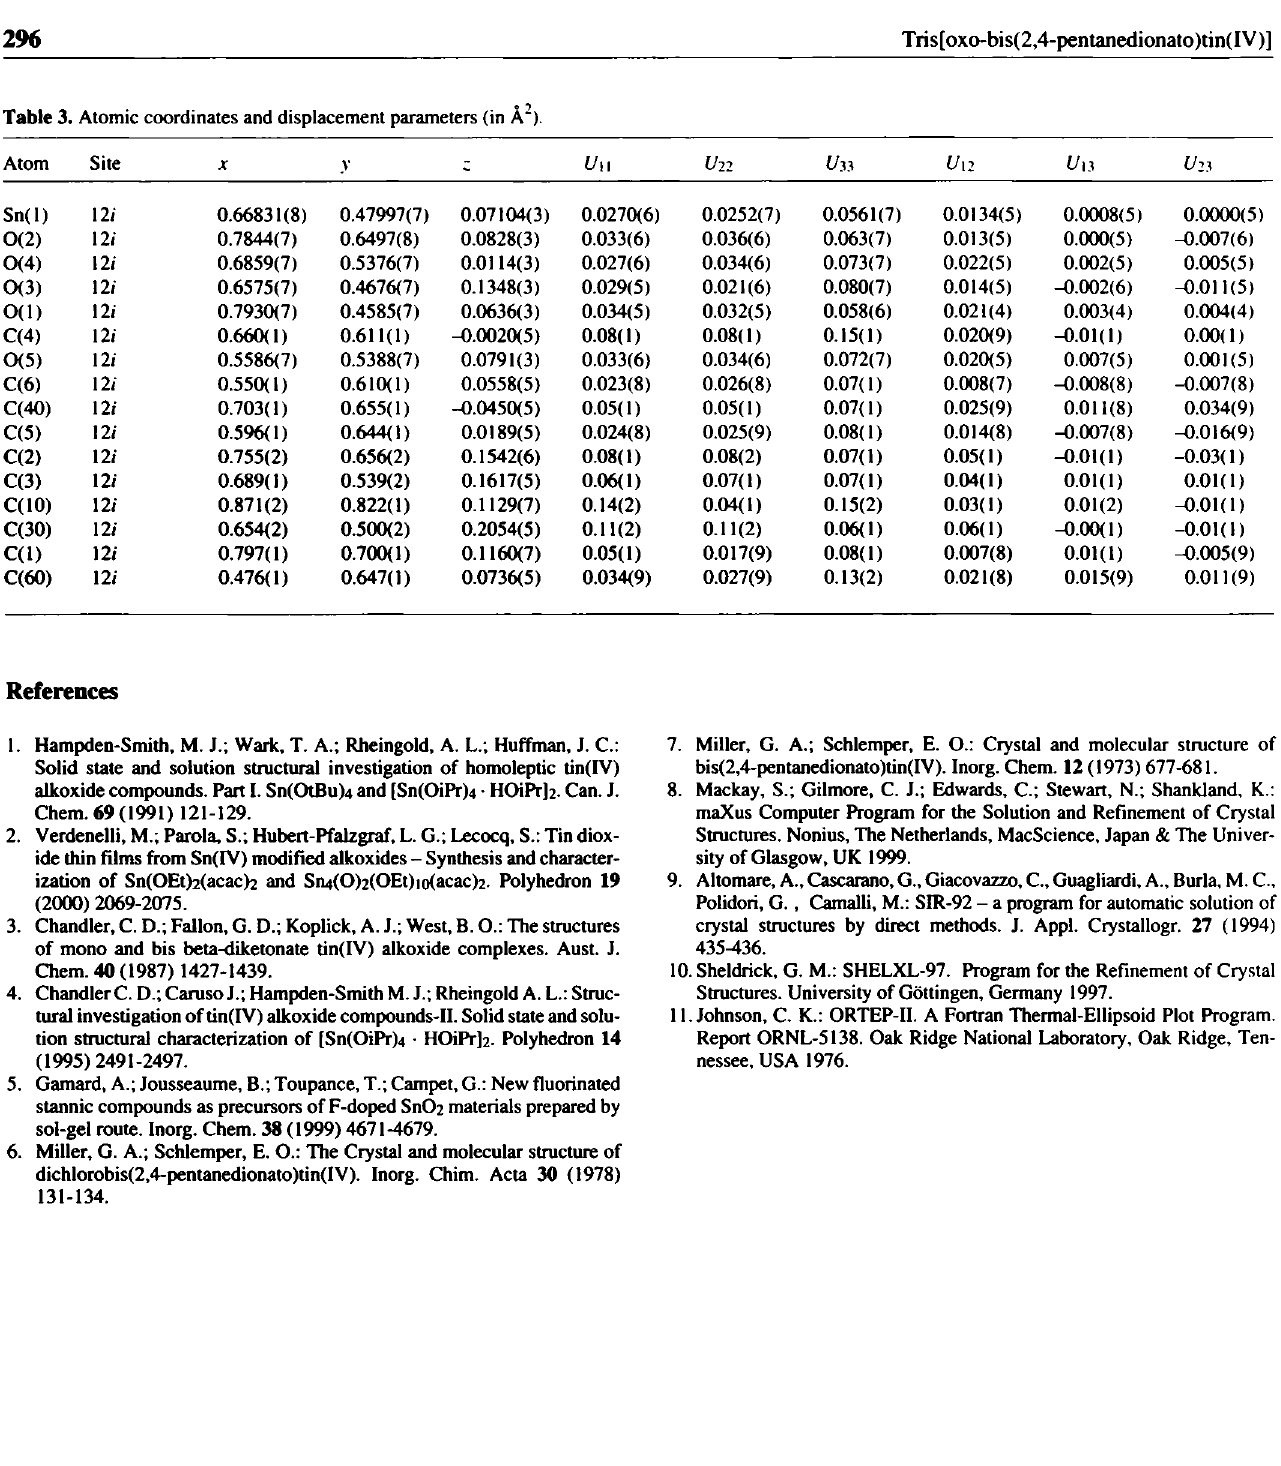
Table 3. Atomic coordinates and displacement parameters (in A 2